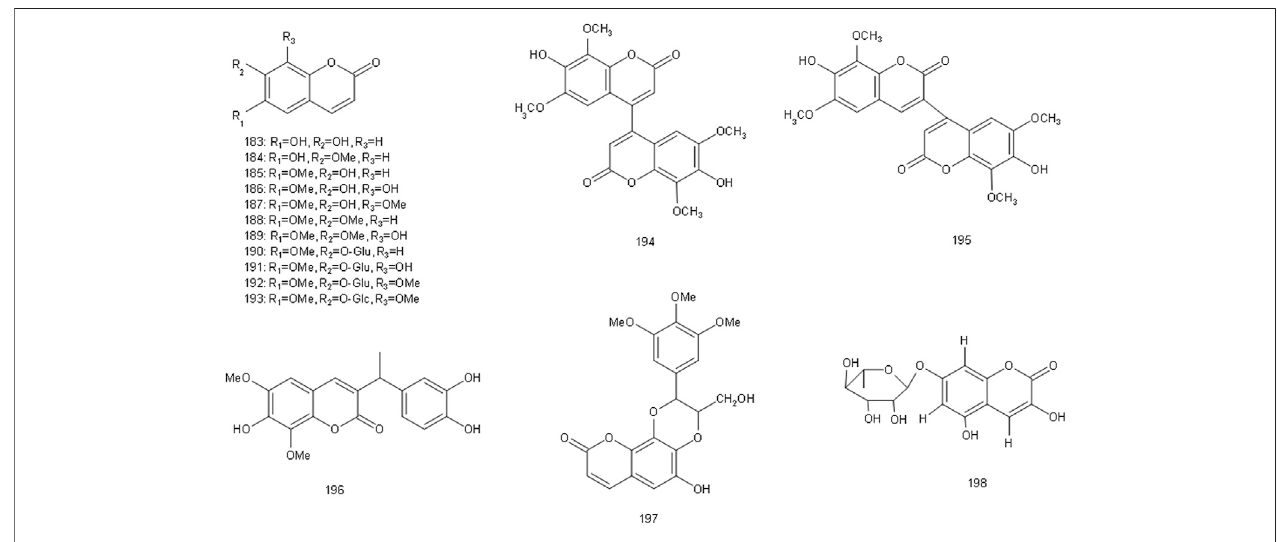
FIGURE 6 | Chemical structures of coumarins identi fi ed in S. glabra extract.